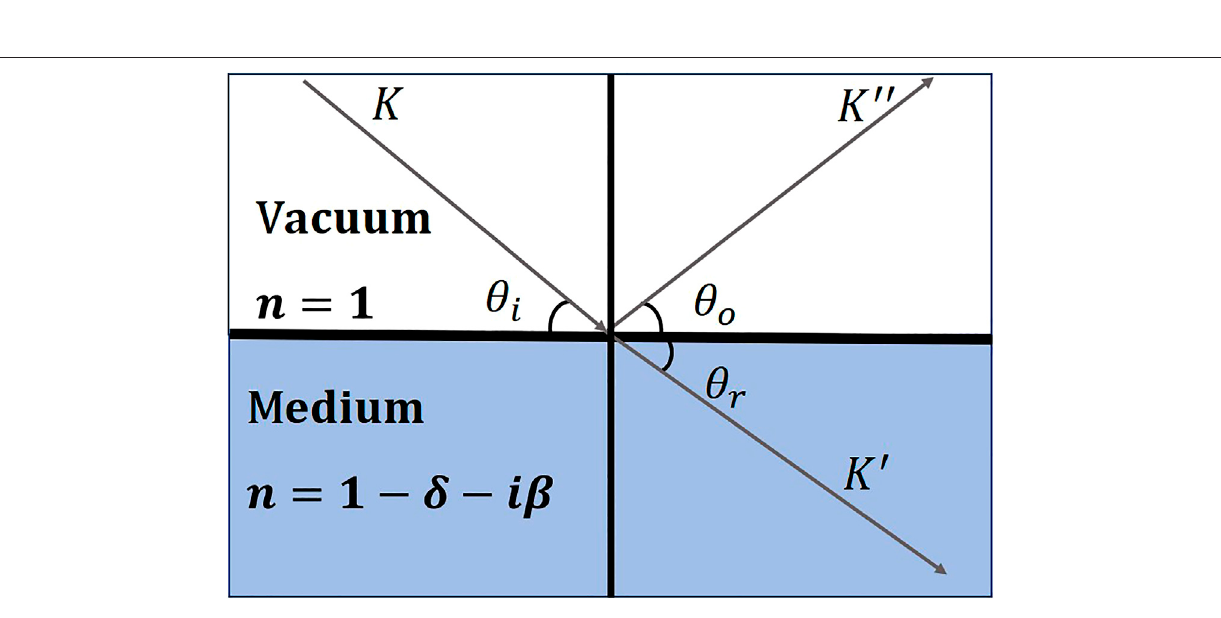
FIGURE 2 | X-ray re fl ection on a smooth